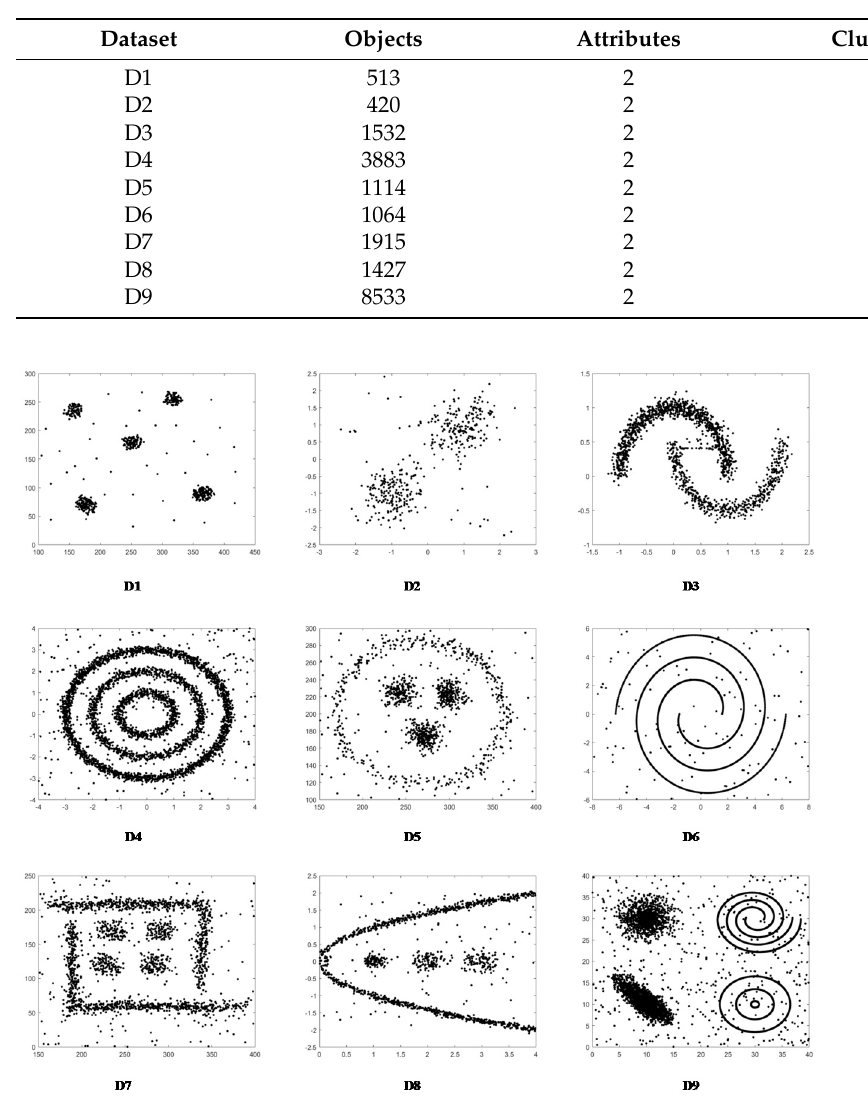
Figure 5. The original data of the nine synthetic data sets.